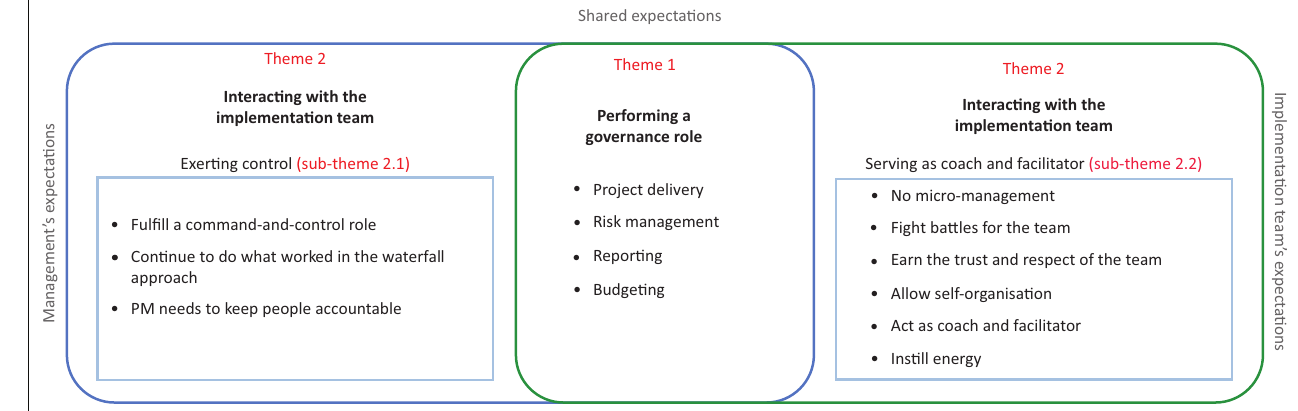
FIGURE 1: Management and implementation teams’ expectations from project managers in an agile environment within a large corporate organisation